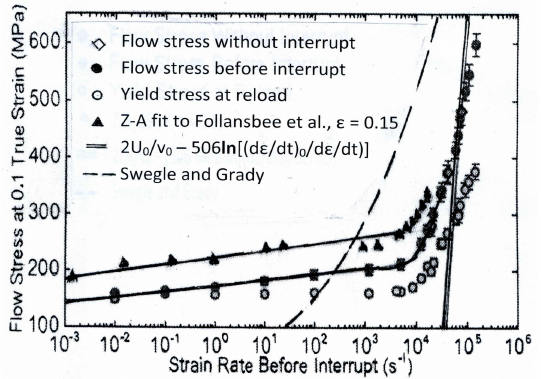
Figure 1. Comparison of Follansbee et al. [1], ε = 0.15, SHPB measurements fitted to a Z–A rela- tionship [7] and follow-on ε = 0.10 measurements reported by Lea et al. [2], also shown in relation to extrapolation to the lower stress regime of experimental Swegle and Grady [5] and dislocation mechanics-based shock [4]